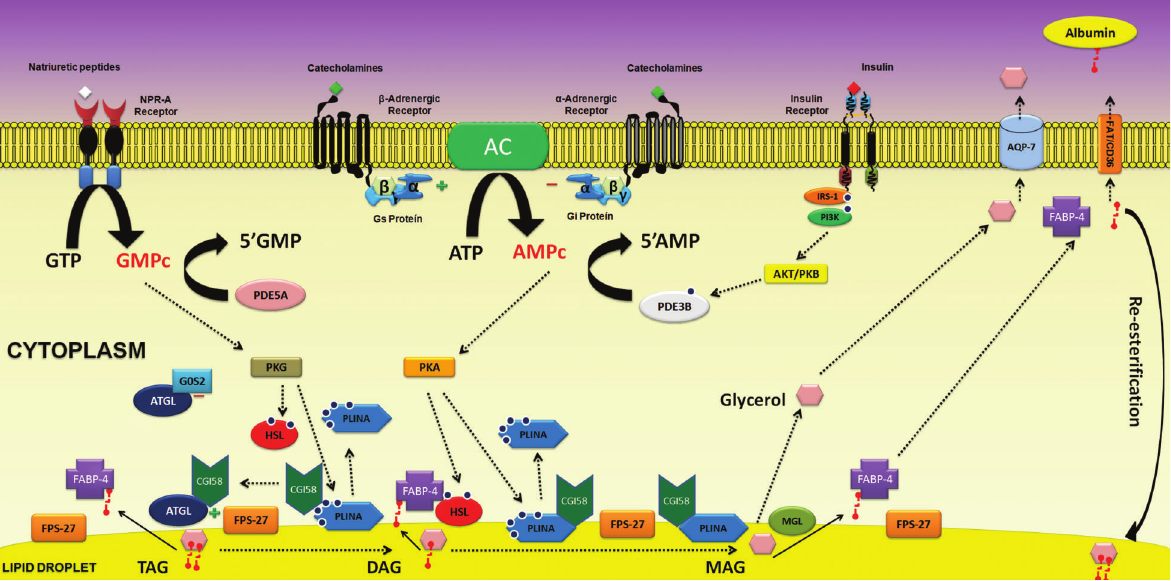
Figure 2. Major pathways involved in lipolytic regulation: the signal transduction pathways of catecholamines via adrenergic [( b ) stimulatory and ( a 2) inhibitory] receptors and atrial natriuretic peptides via type A receptor (NPR-A); protein kinases (PKA and PKG) involved in the phosphorylation of target proteins; phosphorylation of HSL promoting translocation from cytosol to the surface of lipid droplets. Perilipin phosphorylation induces a major physical change on the droplet surface, which facilitates the action of HSL and starts lipolysis. Association of HSL with fatty acid binding protein (FABP-4) favors hydrolase action of HSL. Insulin anti-lipolytic action on adipocytes, through insulin receptors stimulation, leads to the activation of phosphodiesterase-3B (PDE-3B) promoting cAMP degradation. PDE-5A: phosphodiesterase 5A; ATGL: adipose tissue triacylglycerol lipase; FABP-4: fatty acid binding protein 4; GC: guanylate cyclase, Gi: inhibitory G protein; Gs: stimulatory G protein; HSL: hormone-sensitive lipase; PLINA: perilin; FPS-27: fat- specific protein 27; G0S2: G0/G1 switch gene 2; MGL: monoacylglycerol lipase; FFAs: free fatty acids; NPR-A: natriuretic peptide receptor-type A; TAG: triacylglycerol; DAG: diacylglycerol; MAG: